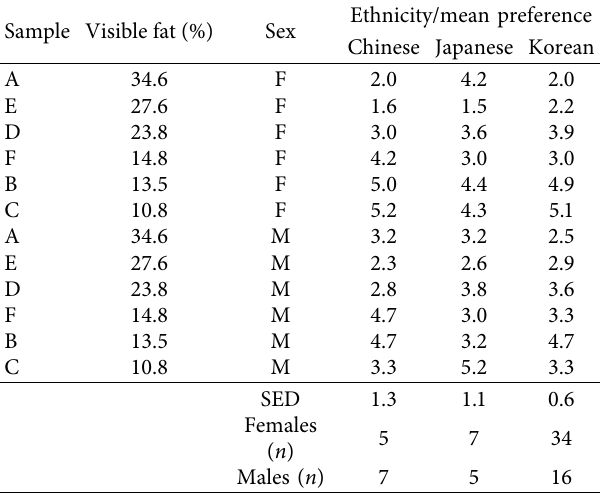
Table 3: The Chinese, Japanese, and Korean mean preference (1 � least preferred; 6 � most preferred) of the samples for the age range of 50+ years separated into females (F) and males (M). Ethnicity/mean preference Sample Visible fat (%) Sex Chinese Japanese